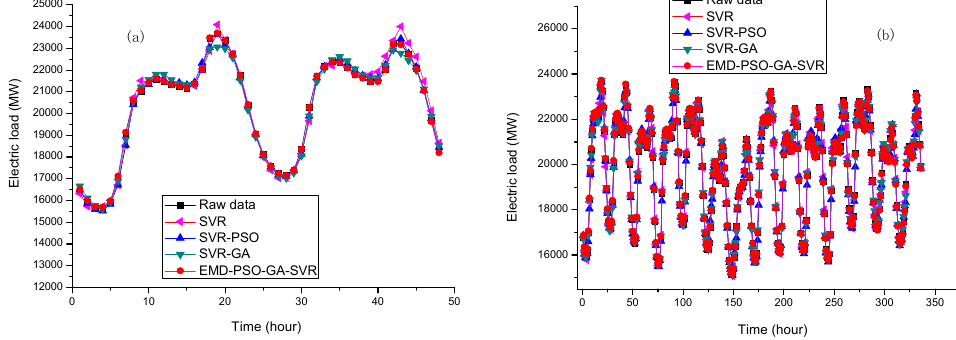
Figure 14. Forecasting performance comparisons (Example 2). ( a ) One-day ahead forecasting from 13 to 14 January 2015; ( b ) One-week ahead forecasting from 2 to 15 February 2015.